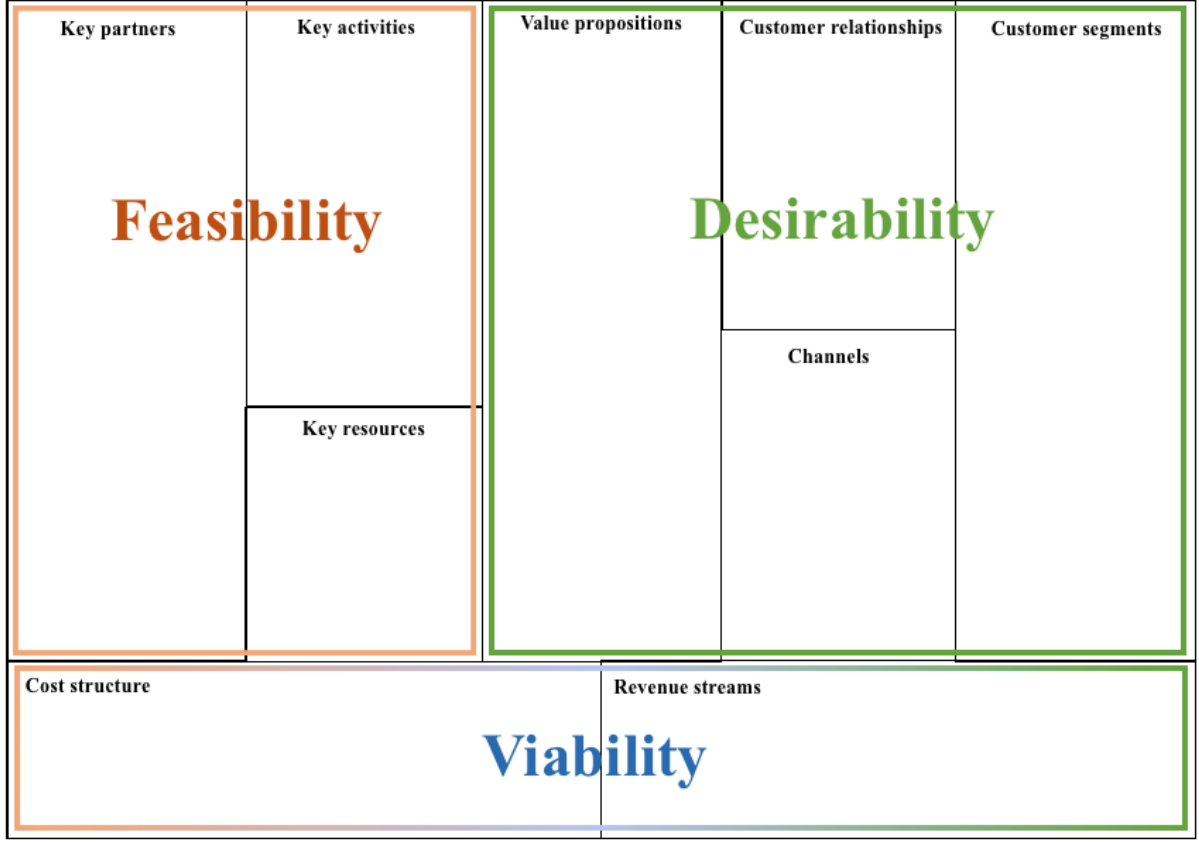
Figure 1. Desirability, feasibility, and viability of the business